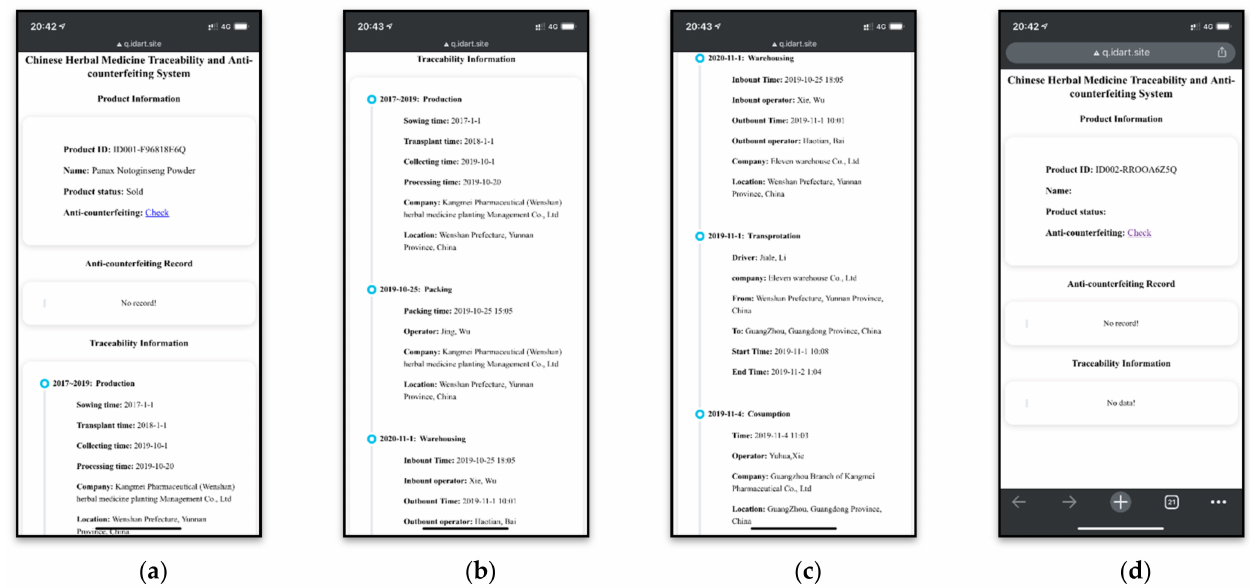
Figure 14. Traceability information query web page of the prototype system. ( a – c ) Traceability information for the authentic and counterfeit tag. ( d ) Traceability information for the forged tag.